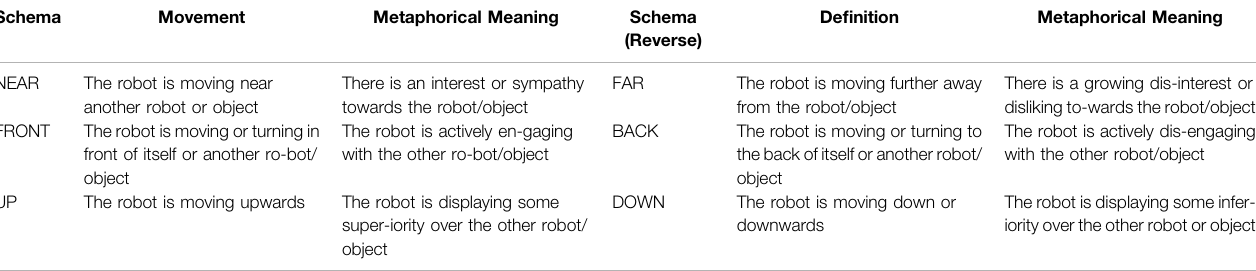
TABLE 1 | A listing of image schemas with their robotic realizations, with additional potential for metaphorical meaning. Each row contains a schema and its inverse.